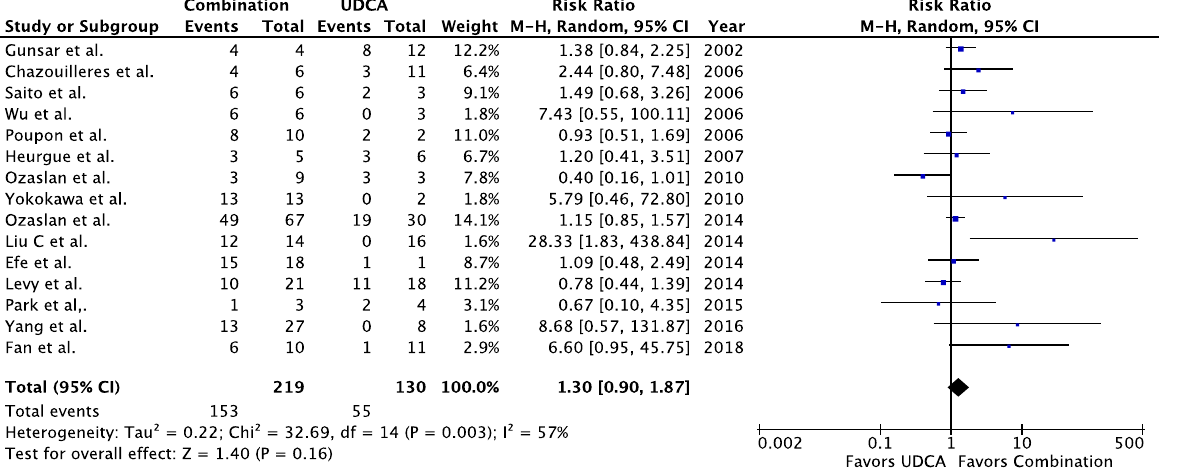
Figure 2. Biochemical improvement in AIH-PBC patients treated with combination therapy vs. UDCA alone. UDCA = ursodeoxycholic acid, Combination = UDCA + [corticosteroids and/or antimetabolites].